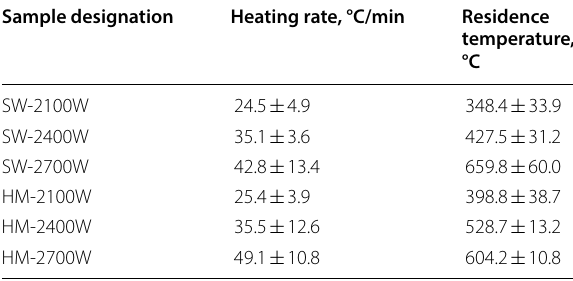
Table 3 Pyrolysis temperature